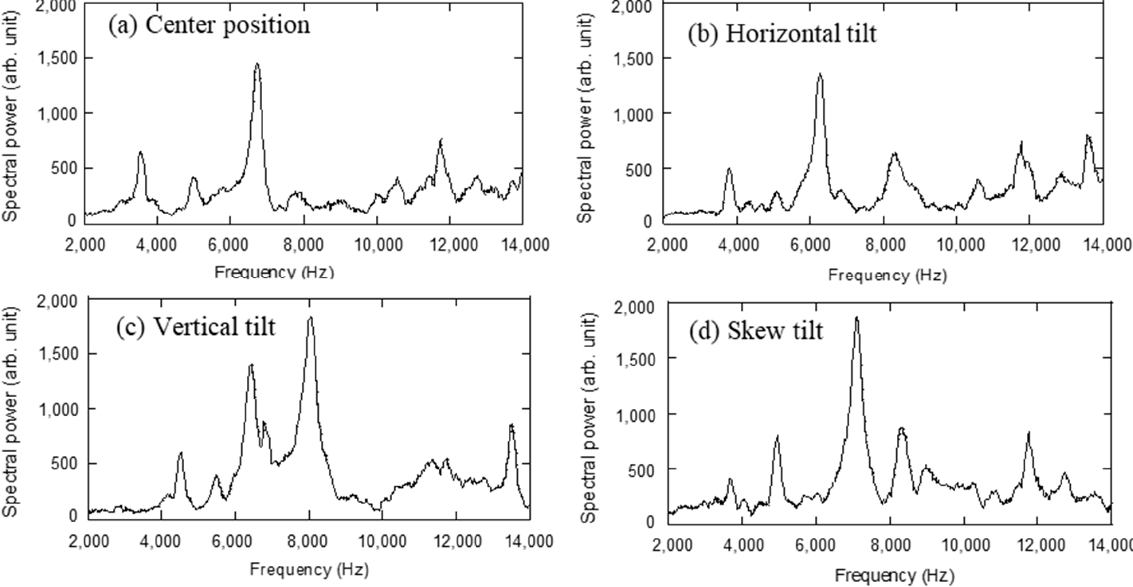
Figure 4. Laser-induced vibration spectra at different tilt directions of screw head: ( a ) center position, ( b ) horizontal tilt, ( c ) vertical tilt, and ( d ) skew tilt.